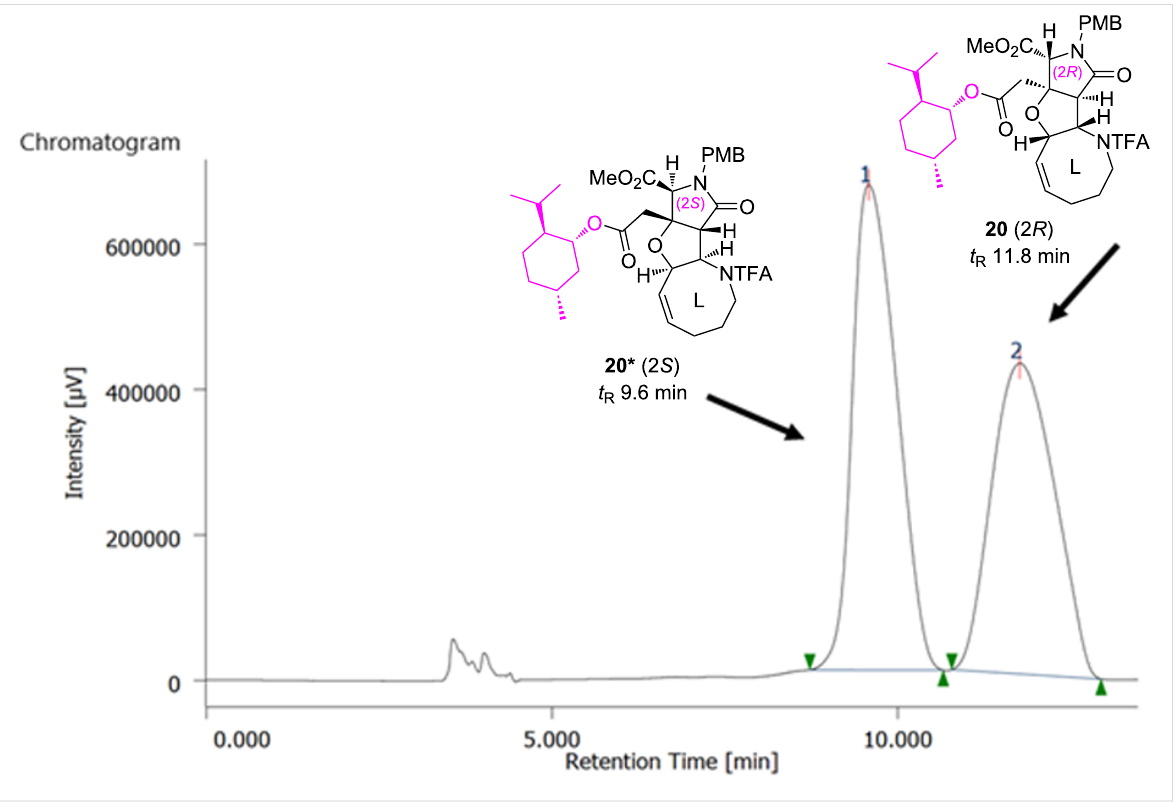
Figure 6: Chiral HPLC profiles for the separation of menthyl ester diastereomers 20* and 20 . Conditions: 4.6 × 250 mm CHIRALPAK IC column, EtOH/hexane 1:19, 1 mL/min, 40 °C, 254 nm, t R 9.6, 11.8